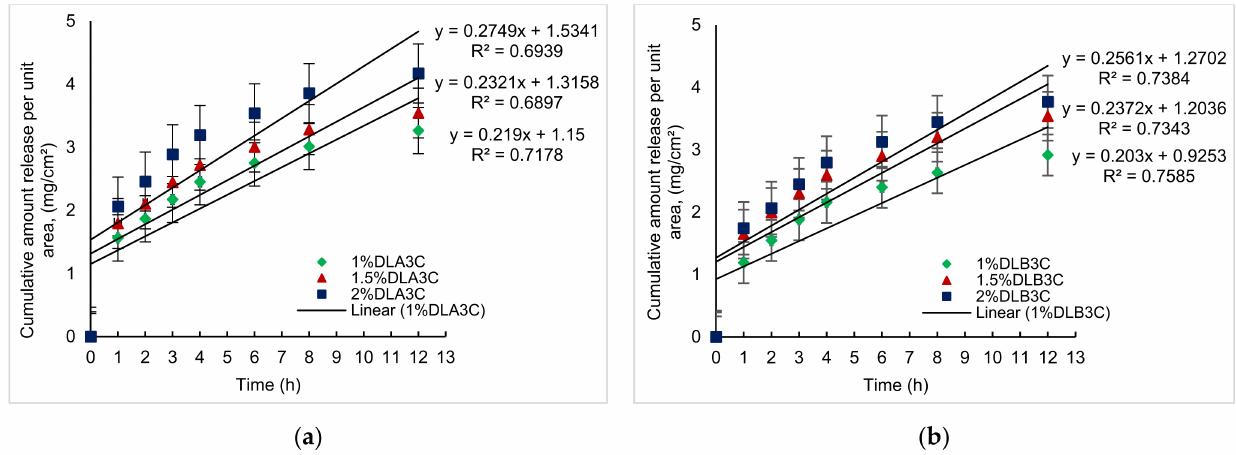
Figure 9. Plotted graph for in vitro permeation profiles of DS medicated: ( a ) DL A 3C (1 to 2 % w / v ); ( b ) DL B 3C (1 to 2% w / v ).